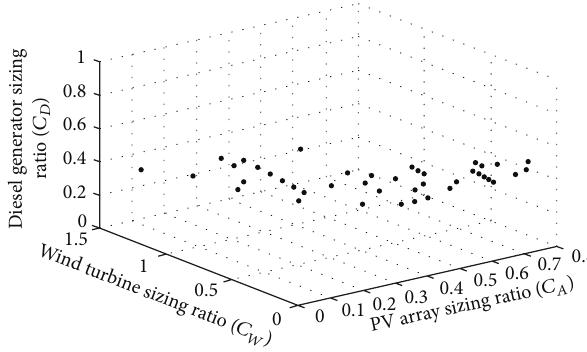
Figure 6: Design space for the proposed hybrid PV/wind/diesel system subject to